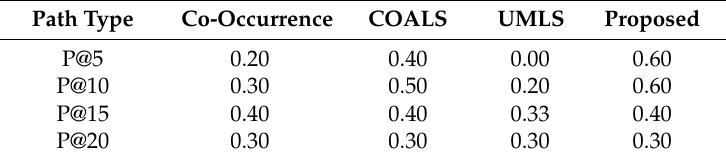
Table 6. Comparison of precision at n (where type 1 = true and both type 2 and 3 = false). Path Type Co-Occurrence COALS UMLS Proposed P@5 0.20 0.40 0.00